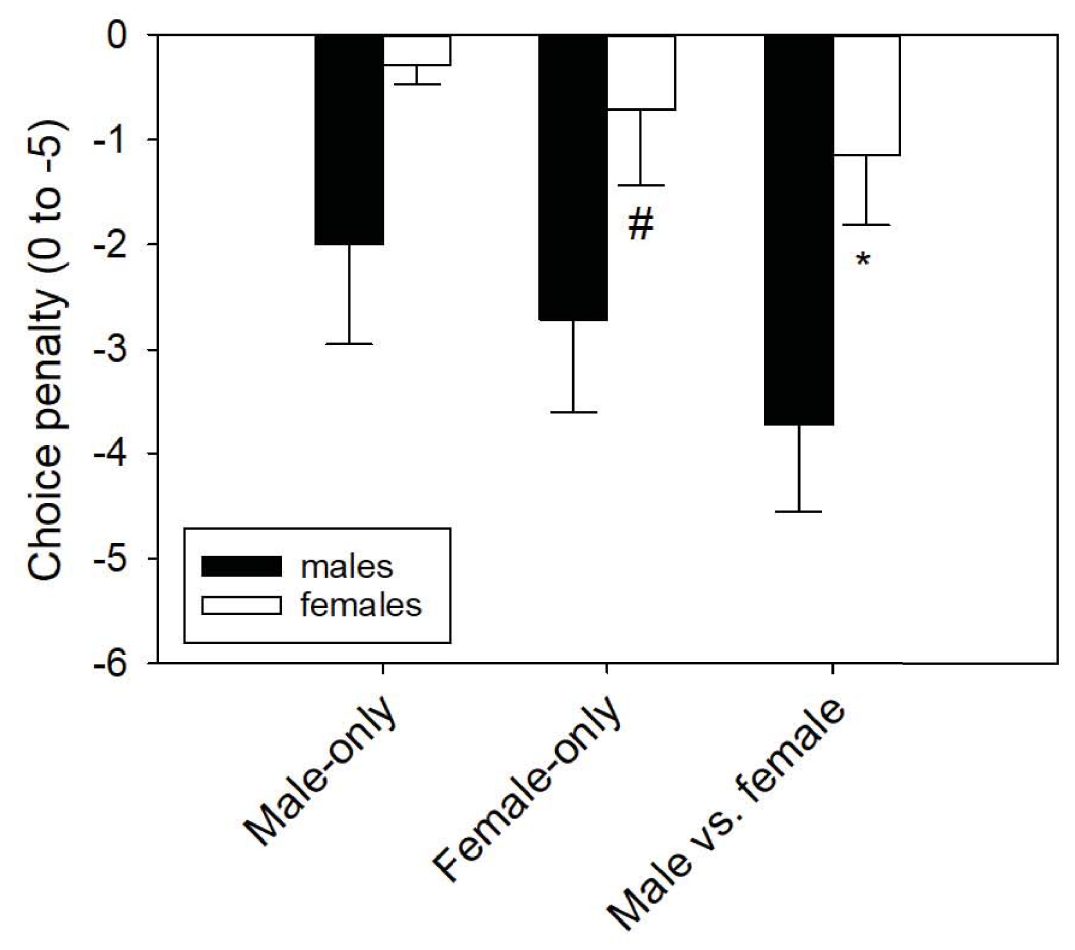
Fig 2. Choice penalty scores. Female tegus had less negative choice penalty scores compared to male tegus in the Y-maze. Choice penalty is a measure of how far the tegu moved in the non-target arm (unscented arm in Male- and Female-only trials; same-sex arm in Male vs. female). � P < 0.05 for comparisons within sex per trial type; #0.05 < P < 0.1. Bars are means (-SEM).